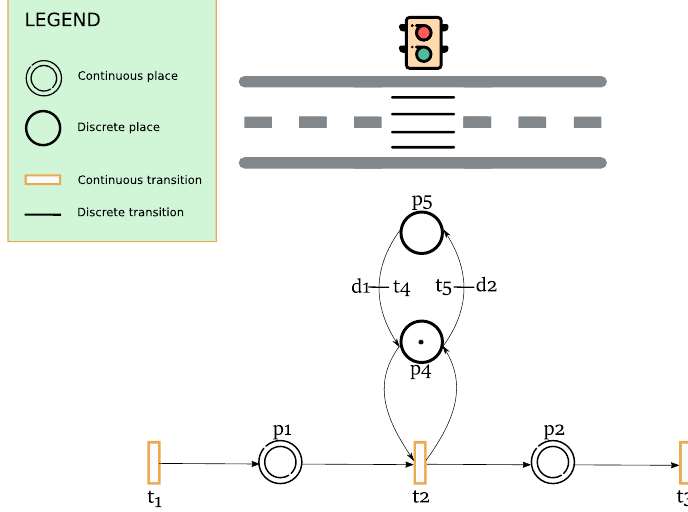
Figure 2. Signalized road and the HPN